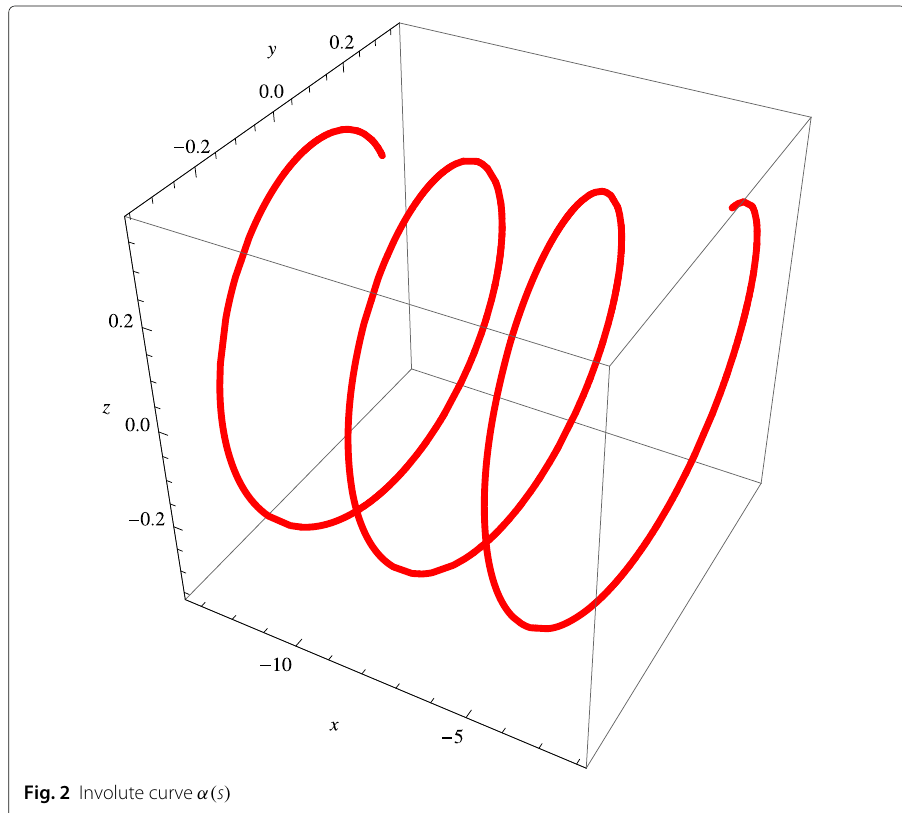
Fig. 2 Involute curve α( s